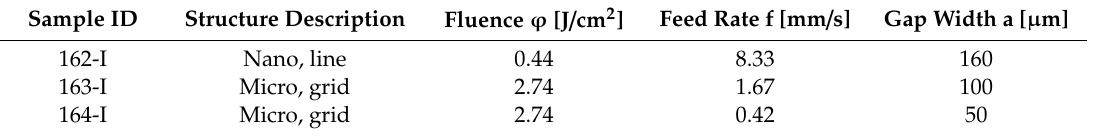
Table 2. Sets of parameters for the laser structuring of 1.4301 stainless steel.